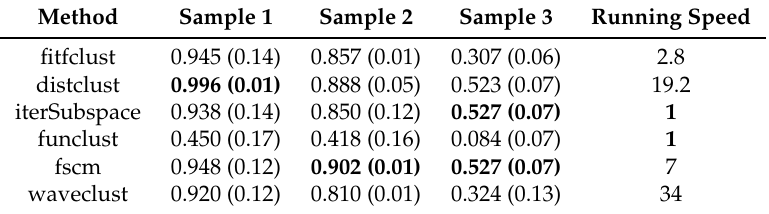
Table 2. Mean Rand Index and (Standard Deviation) on 100 simulations of the tree samples. Each algorithm run in at most a few seconds on our simulated data sets. Comparison in speed between algorithms is given as a multiple of the fastest which is set arbitrarily to 1.